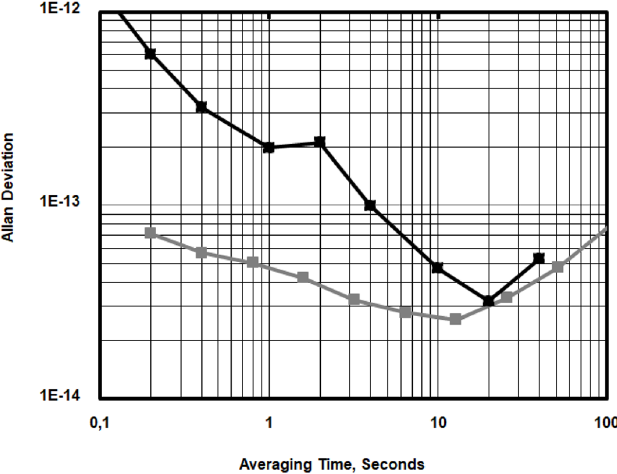
Figure 2. Best performances obtained on a Quartz oscillator at 5MHz. The fl icker frequency modulation (FFM) fl oor is in the range of 2.5 (cid:1) 10 (cid:3) 14 – 3.2 (cid:1) 10 (cid:3) 14 for 10 to 20s integration time. In grey the best result measured by Dual Mixer Time Difference Multiplication [8], in black the con fi rmation of this performance measured with time interval analyzer (TIA) [10]. For the black curve, results are limited by the TIA for lower averaging time and by aging for upper averaging